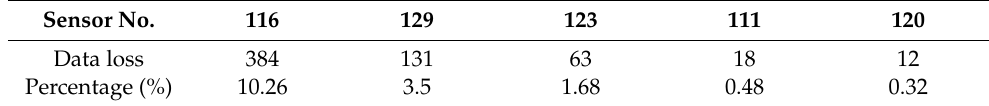
Table 1. Data loss rate for some nodes with one month.